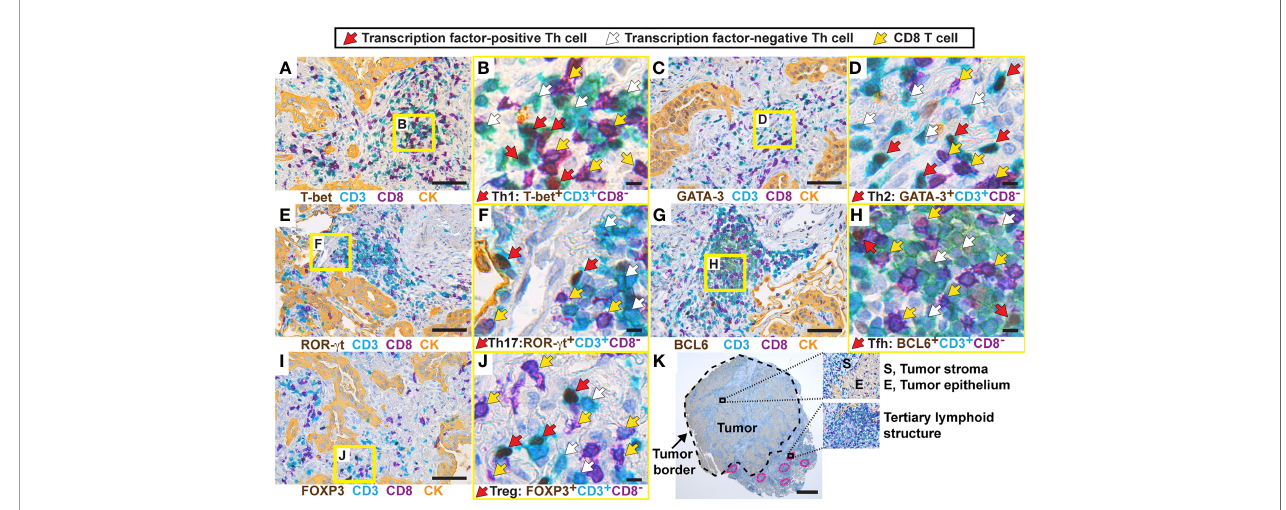
FIGURE 1 | Establishment of a multiplex chromogenic IHC assay to detect fi ve different Th subsets in human lung tumors. From each tumor (here, a lung adenocarcinoma), fi ve 3 m m-thick serial sections were generated. T cells were immunostained with anti-CD3 (teal) and anti-CD8 (purple) mAbs, and all Th cells were identi fi ed as CD3 + CD8 - . Th subsets were detected using mAbs against subset-de fi ning transcription factors (brown). Immunostaining of cytokeratins (CK) was used to visualize the tumor epithelium (yellow), and tumor stroma was de fi ned as the cytokeratin-negative areas within the tumor border. Images containing higher than average densities of positive cells were selected for this fi gure. (A) Th1 cells were identi fi ed as T-bet + CD3 + CD8 - cells, and the squared area indicated in yellow is shown in (B) with higher magni fi cation. (C, D) Th2 cells were identi fi ed as GATA-3 + CD3 + CD8 - . (E, F) Th17 cells were identi fi ed as ROR- g t + CD3 + CD8 - . (G, H) Tfh cells were identi fi ed as BCL6 + CD3 + CD8 - . (I, J) Treg cells were identi fi ed as FOXP3 + CD3 + CD8 - . (K) Image of a whole tumor and magni fi ed areas illustrating three microanatomical regions that were analyzed in this study. The tumor border is marked with a black stippled line, and tertiary lymphoid structures are marked with a pink stippled line. In the high magni fi cation images (B, D, F, H, J) , arrows indicate examples of positive/negative cells: red arrows point at transcription factor-positive Th cells (teal cells with brown nuclei), white arrows point at transcription factor-negative Th cells (teal cells with hematoxylin-stained purplish blue nuclei), and yellow arrows point at CD8 + T cells (purple). Original magni fi cation: 400x (A – J) , 25x (K) . Scale bars: 50 m m (A, C, E, G, I) ; 5 m m (B, D, F, H, J) ; and 1 mm (K)